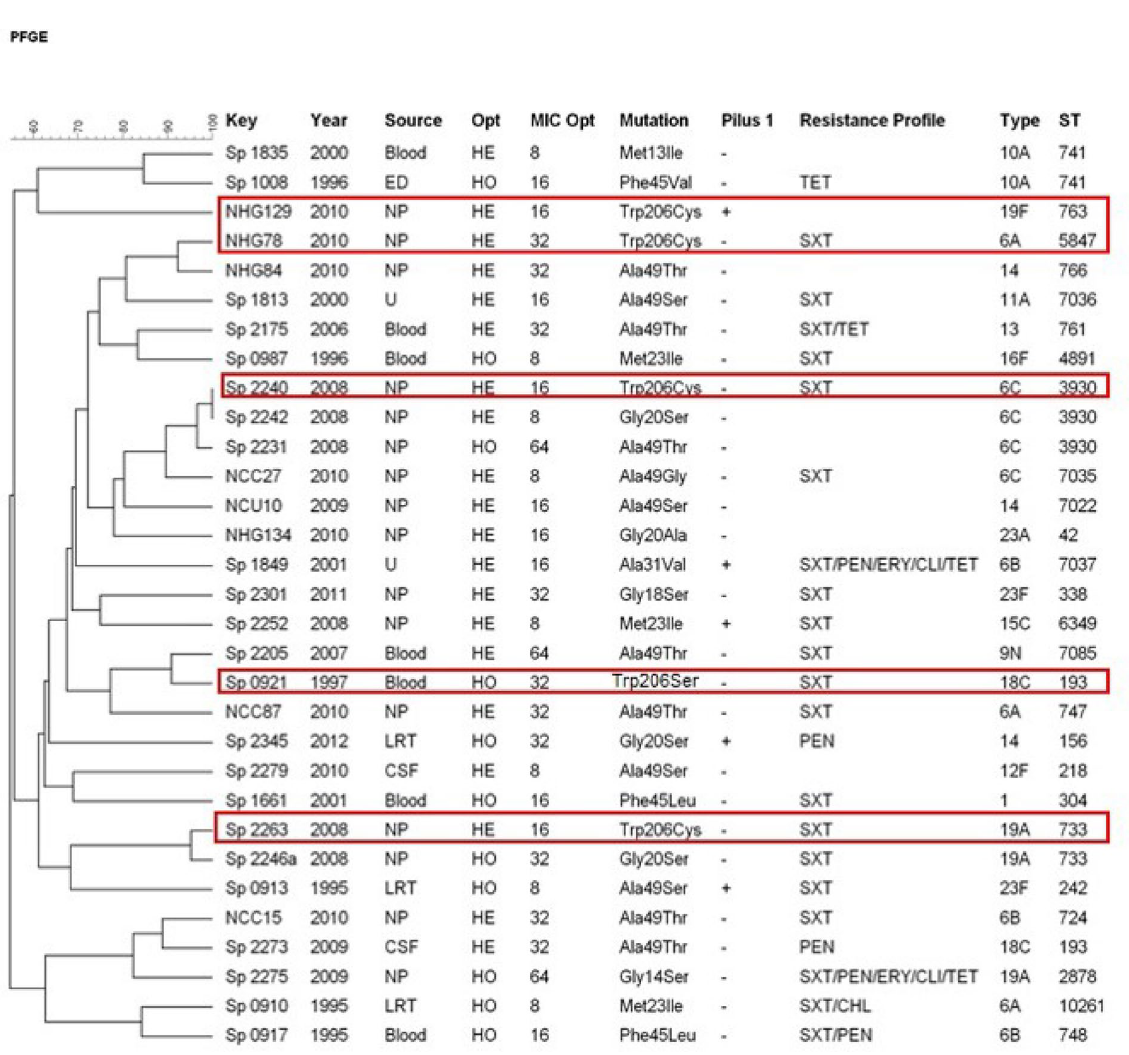
Figure 1. UPGMA dendrogram generated by using BioNumerics v.7.6 based on PFGE profiles of 31 optochin-resistant Streptococcus pneumoniae strains isolated in Brazil. The five a tp A gene mutants described in this work are marked in red. Ala alanine, CLI clindamycin, CHL chloramphenicol, CSF cerebrospinal fluid, Cys cysteine, ED eye discharge, ERY erythromycin, Gly glycine, HE heterogeneous, HO homogeneous, Ile isoleucine, Leu leucine, LRT low respiratory tract, Met methionine, MIC minimum inhibitory concentration, NP nasopharyngeal carriage, Opt optochin, PEN penicillin, Phe phenylalanine, Ser serine, ST sequence type, SXT sulfamethoxazole-trimethoprim, TET tetracycline, Thr threonine, Trp tryptophan, Val valine, U